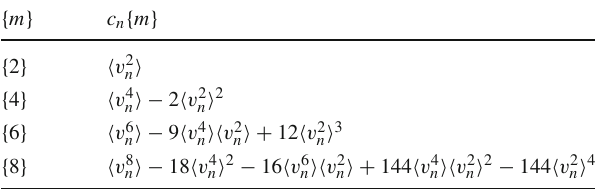
Table 3 One-harmonic cumulants up to order eight